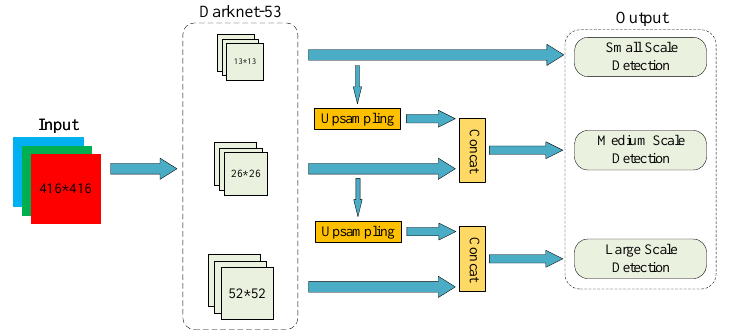
Figure 1. The structure of YOLOv3